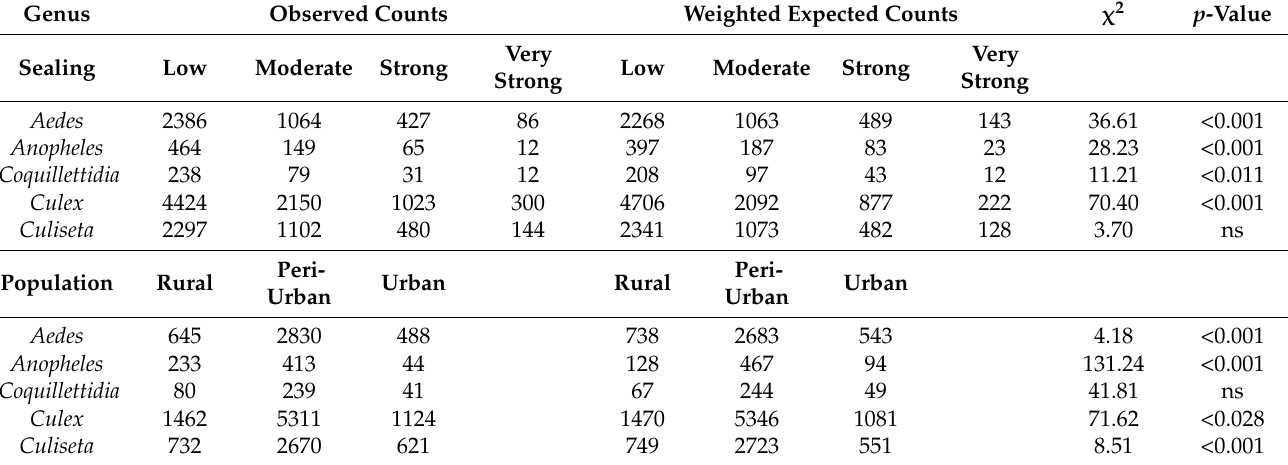
Figure 3. Boxplots comparing rarefied species richness, ( a , b ), and effective Shannon diversity (number of equally common species), ( c , d ), by urbanization level based on two indicators, soil sealing and human population density , using years as replicates. Thick black lines denote medians, first and third quartiles are shown by lower and upper hinges, and whiskers represent distance from hinge to the farthest value within the 1.5 interquartile range. Outliers are displayed individually. Symbols * and ** indicate statistical significance at α < 0.05 and < 0.01 based on t-tests with the Bonferroni–Holm correction (adjusted p -values displayed). Table 1. Chi-square test of homogeneity for the number of observations per urbanization indicator— soil sealing and human population density —of five mosquito genera. Expected counts are weighted by the proportion of samples of the four other genera (ns = not